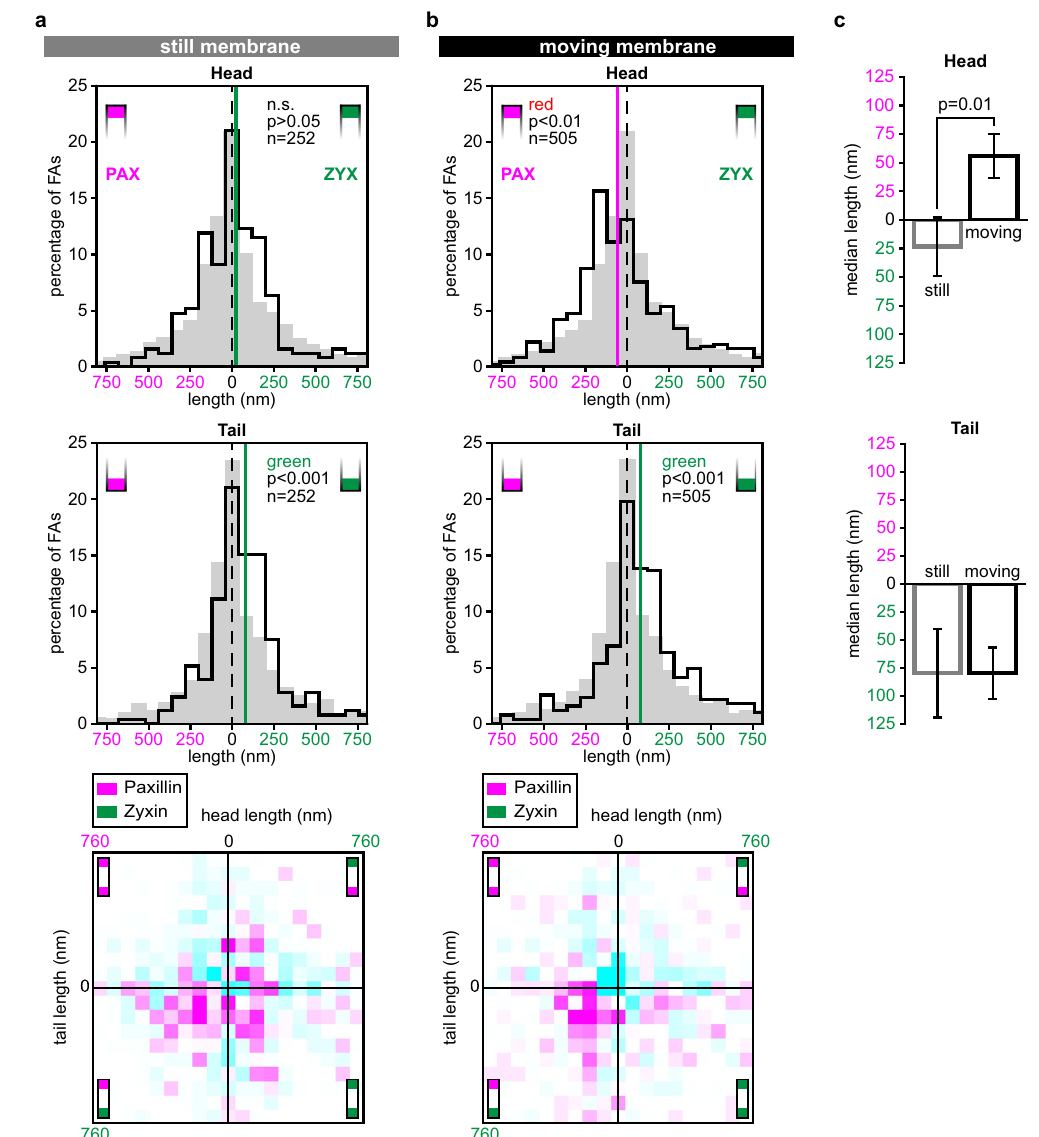
Figure 6. The longitudinal distributions of paxillin and zyxin differ for FAs near static compared to moving membrane edges. ( a ) Histograms of head (top) and tail (middle) protrusion lengths for FAs near static membrane edges (not protruding or retracting) in U2OS cells co-expressing paxillin-mCherry and zyxin- GFP subjected to overnight serum-starvation and HGF-treatment. Pax/pax reference histograms showing the distribution of the pax/pax reference set are plotted in grey. p values generated compared to the reference histograms (two-sided Mann Whitney U tests), n gives number of analysed FAs. Vertical lines: median protrusion lengths. Bottom: 2D-histogram combining head and tail protrusion lengths for each individual FA. Colours represent the difference compared to the relative distributions of the reference set. White: below threshold, magenta: increase relative to reference set, cyan: decrease relative to reference set. Colour intensity represents magnitude of the difference (for scale and threshold see Materials and methods). ( b ) Histograms of head (top) and tail (middle) protrusion lengths for FAs near moving membrane edges. Grey histograms, vertical lines, n-numbers and statistical tests as above. Bottom: 2D-histogram combining head and tail protrusion length for each individual FA. Colours as above. ( c ) Comparison of head/tail length for FAs near still (grey) and moving (black) ventral membrane edges, p values are generated by two-sided Mann Whitney U tests. Errorbars show standard error of the mean